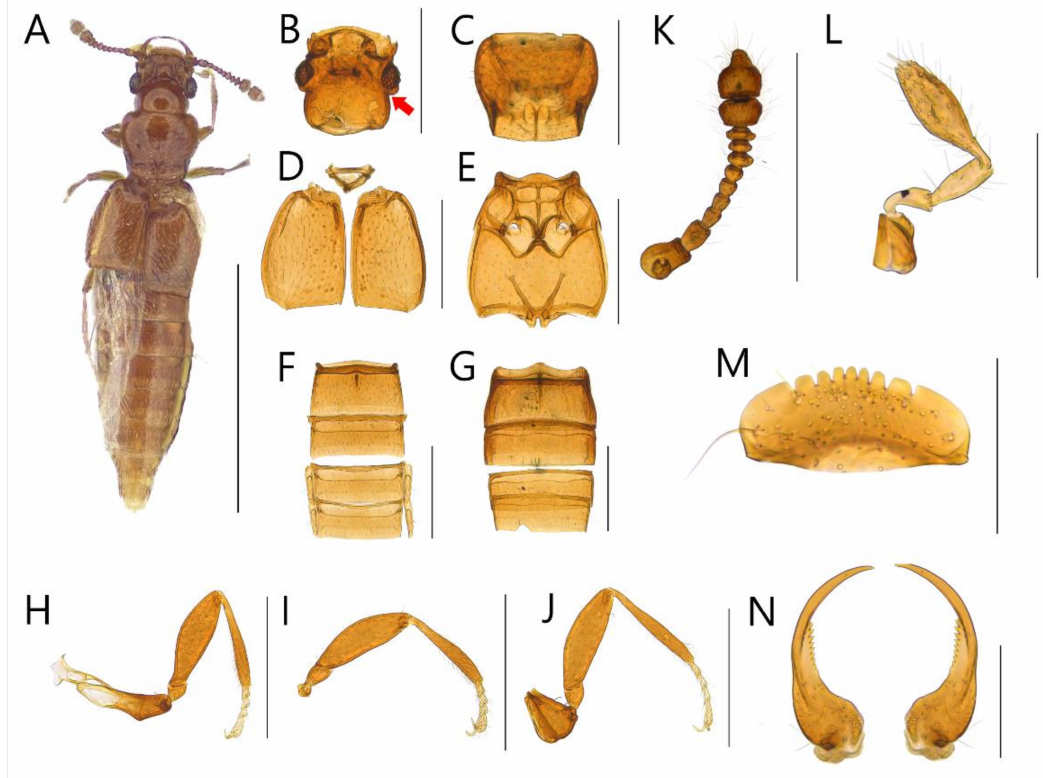
Figure 2. Male habitus of Edaphus haenamensis sp.n.: ( A ) dorsal view; ( B ) head; ( C ) pronotum; ( D ) elytra; I meso and metasternum; ( F ) abdominal tergites; ( G ) abdominal sternites; ( H ) fore leg; ( I ) middle leg; ( J ) hind leg; ( K ) antenna; ( L ) maxillary palp; ( M ) labrum; ( N ) mandibles. Scale bars: ( A ) = 1 mm; ( B – K ) = 0.3 mm; ( L – N ) = 0.1